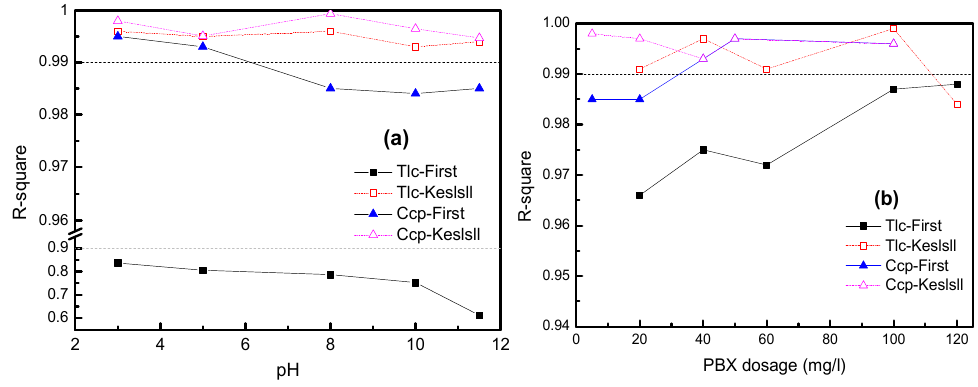
Figure 5. Kinetics simulation on mineral flotation ( a ): collectorless, ( b ): collector.